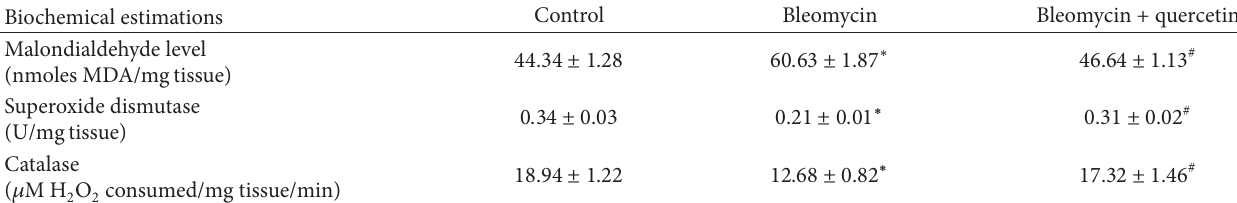
Table 1: Levels or activities of various markers of oxidative stress in the lung tissue of the rats from control and treated groups.